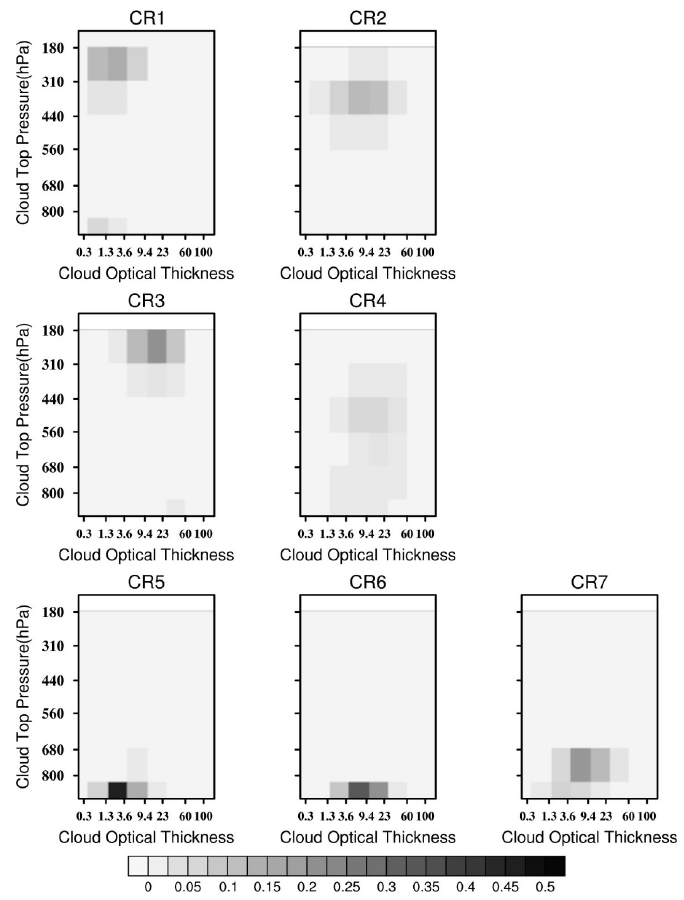
Figure 1. The cloud regime centroids derive from k-means analysis on the combined cloud optical thickness (COT)-cloud top pressure (CTP) histograms of the MODIS Aqua Level 3 daily gridded data. Shading indicates the Probability Density Function (PDF) of joint histograms. Table 1. The mean cloud properties and description for each regime.